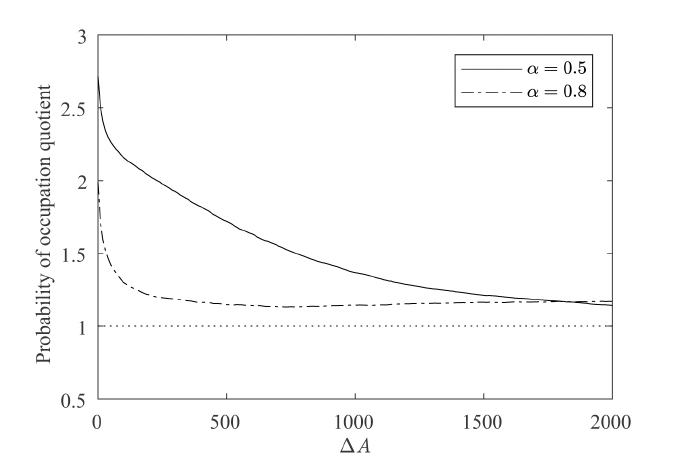
Figure 12. Evolution of the probability of occupation quotient, given by the probability of occupation of a cell adjacent to the irregular nucleus divided by the probability of occupation of a cell adjacent to the regular nucleus, with α = 0.5 and α =